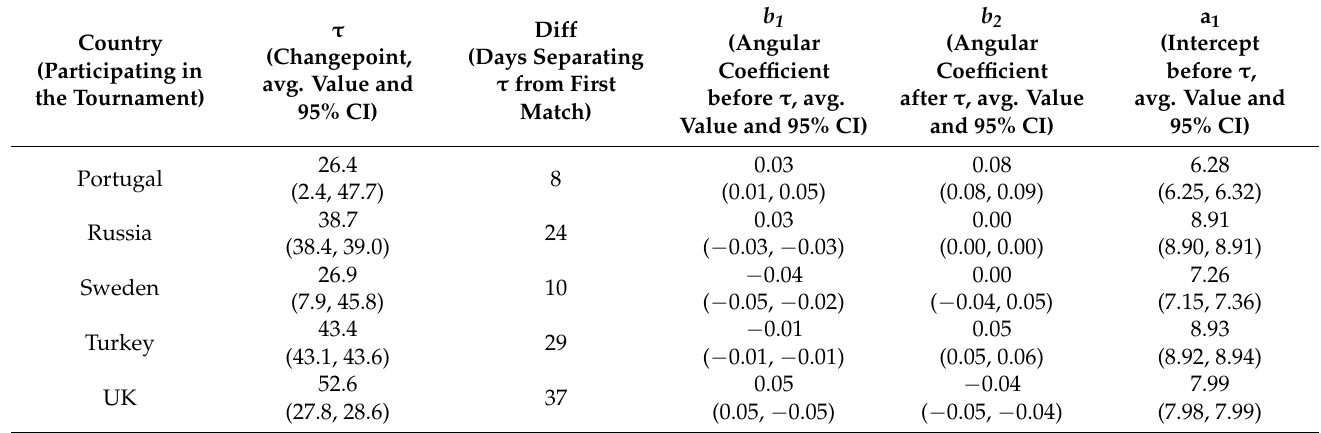
Table 3. Regression parameters for the five countries that break the